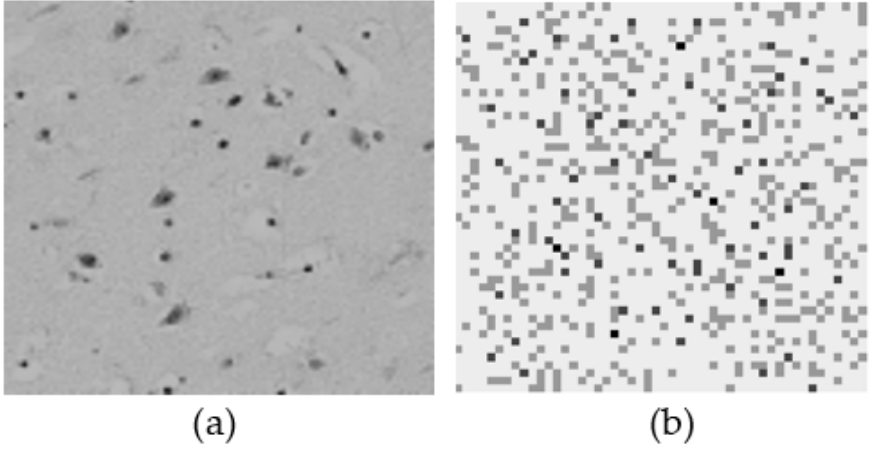
Figure 8. Patterns comparison between real image and simulated image under first order. Isotropic auto-Poisson model: ( a ) Real image and ( b ) Simulated image.